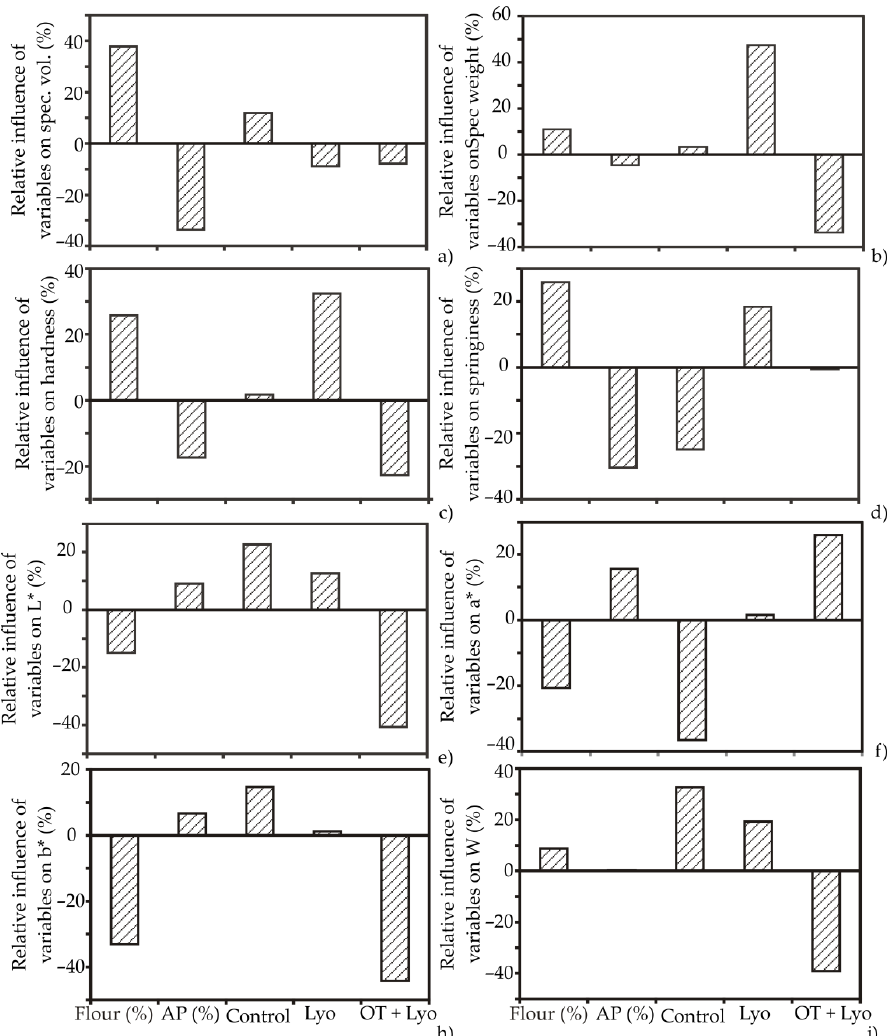
Figure 6. The relative importance of the content of flour, apple powder, and applied treatment on ( a ) specific volume; ( b ) specific weight; ( c ) hardness; ( d ) springiness; ( e ) L*; ( f ) a*; ( h ) b* and ( j ) W, determined using the Yoon interpretation method .